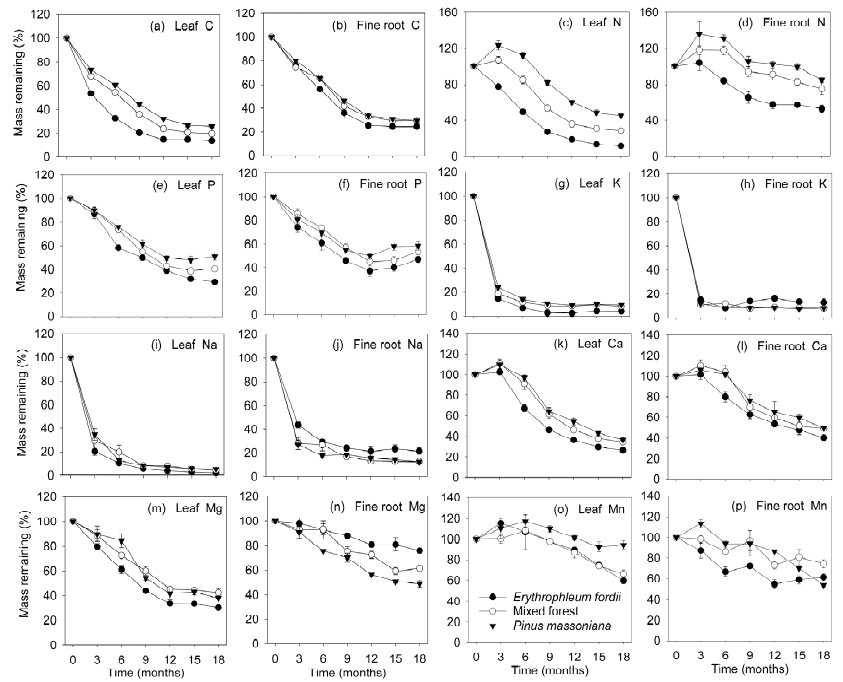
Figure 4. Nutrient quantity dynamics (mean ± standard error, n = 3) in leaf and fine root litter of three subtropical plantations in China.